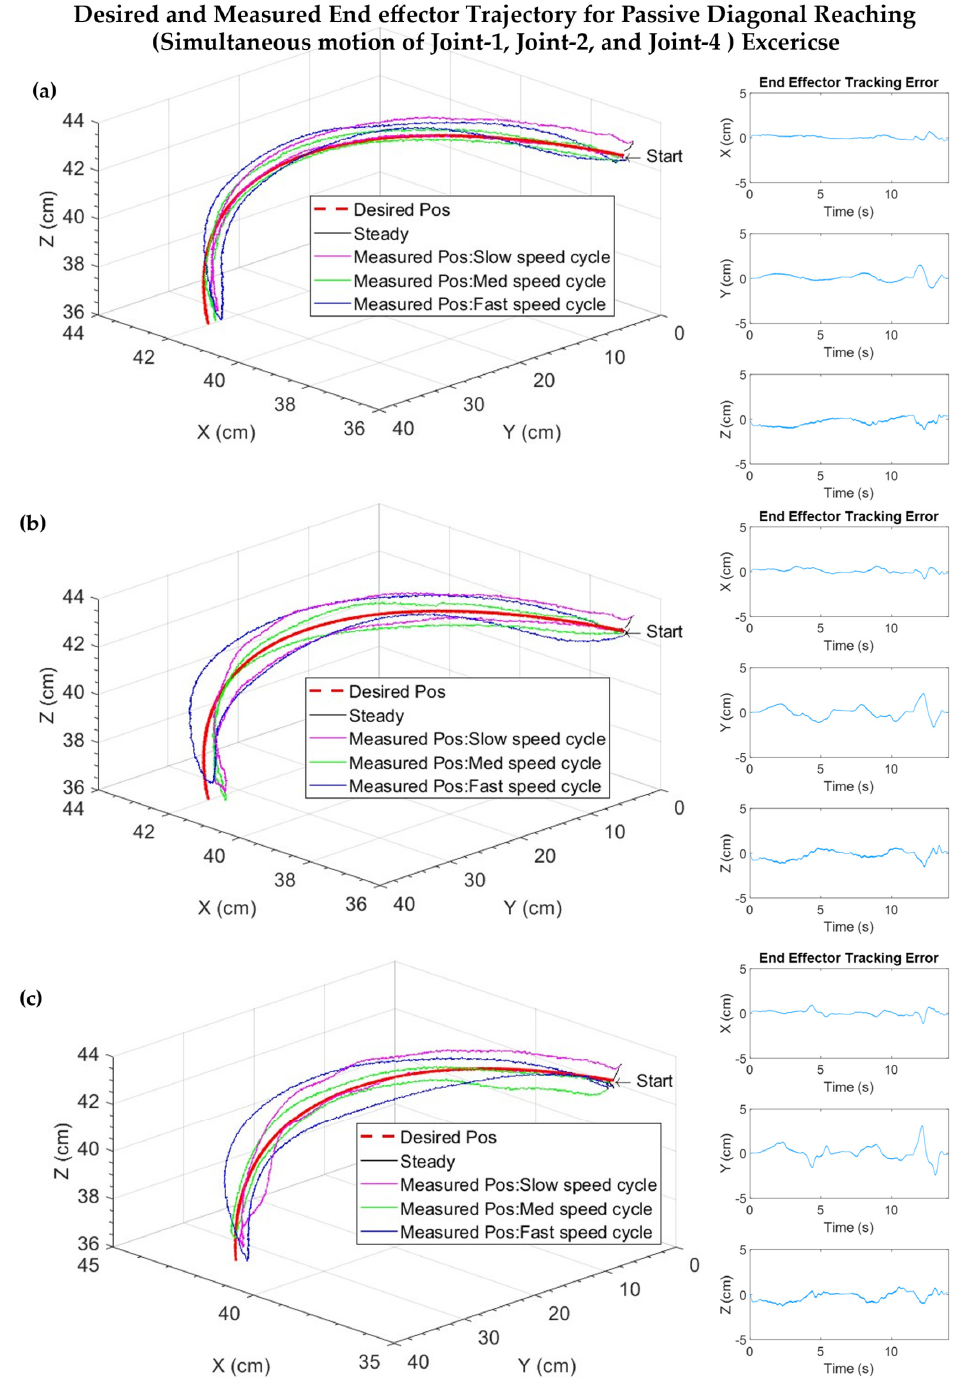
Figure 8. Cartesian trajectories and errors for diagonal reaching exercise with Subject B, while the subject ( a ) remains passive during the motion; ( b ) subject resists the motion; ( c ) subject provides sudden jerk force during the motion.